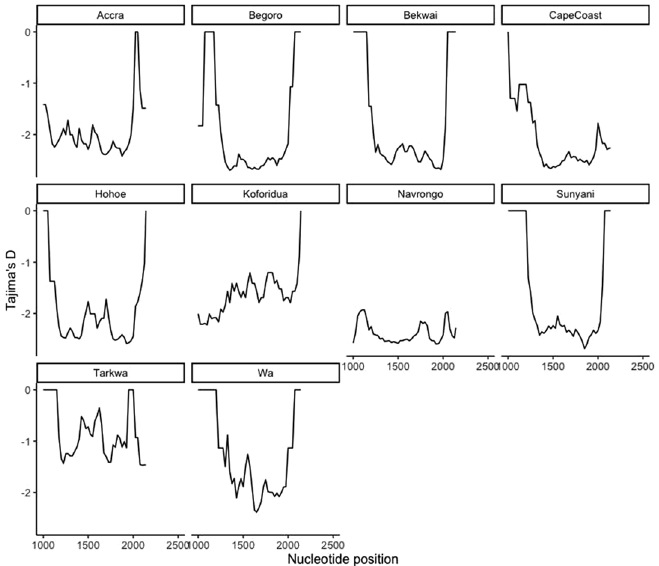
Figure 1. Sliding window plot of Tajima’s D for the pfk13 gene showing distribution by location/site. The computational analysis of the sequences to reveal the nucleotide diversity of the mutations in the pfk13 gene in Ghanaian isolates by study sites. Nucleotide positions is from 1000 to 2181 bp. Window length is 100 bp and step size is 25